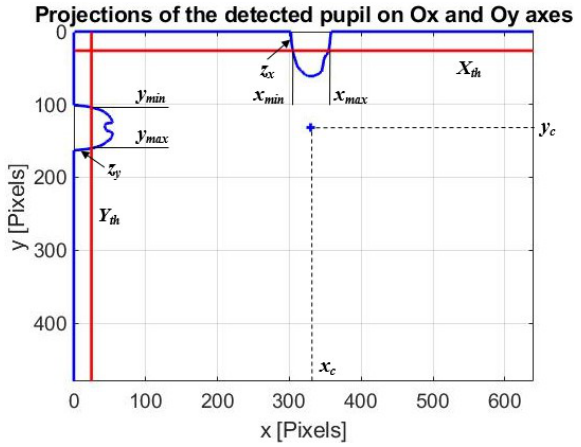
Figure 7. Principle of projection function method algorithm.